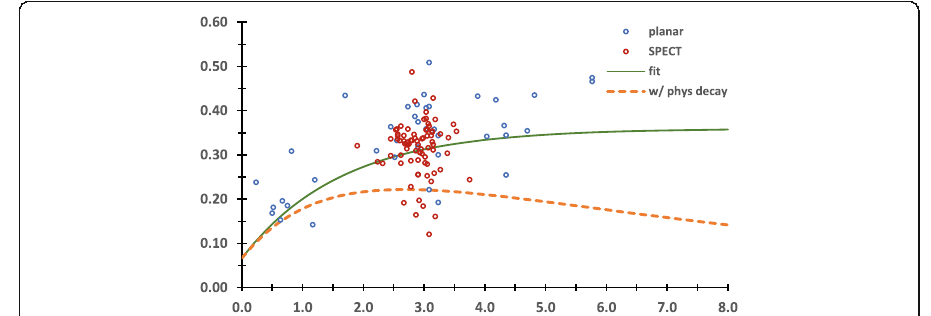
Fig. 4 Fractional activity in kidneys as a function of time post-injection. The red circles, corresponding to data obtained from SPECT represent the clinical imaging time which is spread over time based on clinical logistics. The blue circles correspond to data obtained from planar imaging. The green solid line is the curve obtained from a fit to biological kinetics of DMSA (i.e. decay-corrected to the time of injection); the dotted orange curve corresponds to the actual imaging measurements obtained and reflect both the biological kinetics and physical decay of 99m